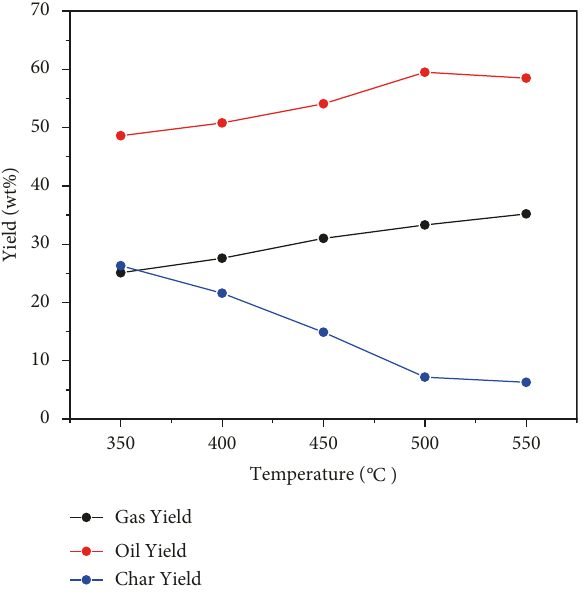
Figure 4: Effect of temperature on pyrolysis of